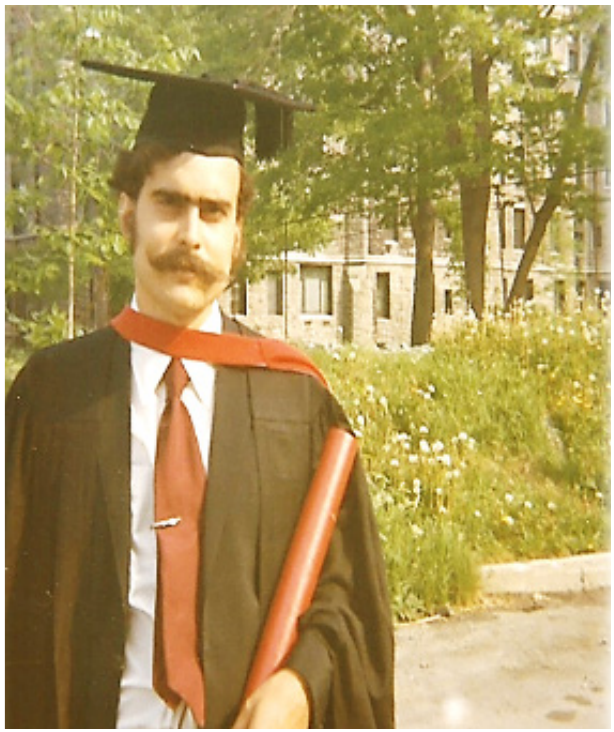
Fig. 5 - Tomas obtained BSc honors in Biochemistry at McGill University.